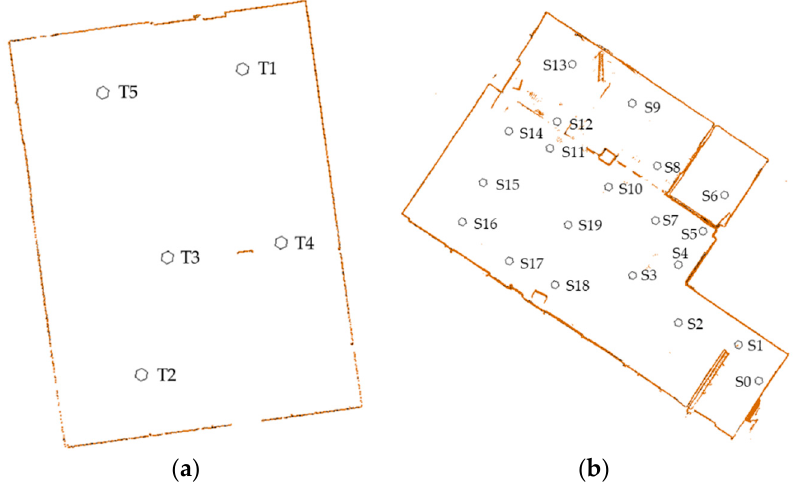
Figure 1. The scan location of the experimental datasets. ( a ) scan locations of dataset SR; ( b ) scan locations of dataset CB. Table 1. Summary of the experimental datasets.